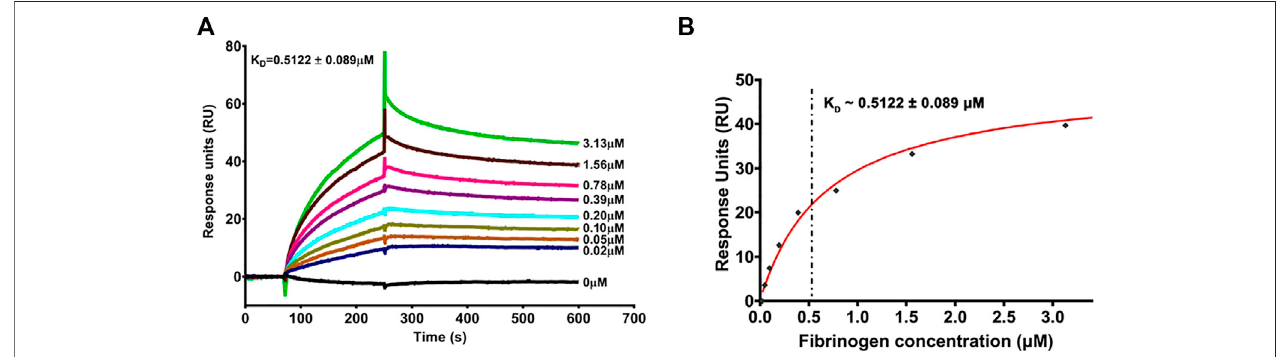
FIGURE 1 | Surface plasmon resonance analysis of dose-dependent interaction between PrP(106 – 126) and human plasma fi brinogen. (A) Sensorgram showing dose-dependent binding between fi brinogen (0.02 – 3.13 μ M) and PrP(106 – 126)-coated CM5 sensor chip. The values against sensorgram tracings in panel A represent concentrations of fi brinogen. (B) The steady-state curve- fi tting model showing the binding af fi nity constant (K D ) at ~ 0.5122 ± 0.089 μ M. Figure is representative of ≥ 3 different